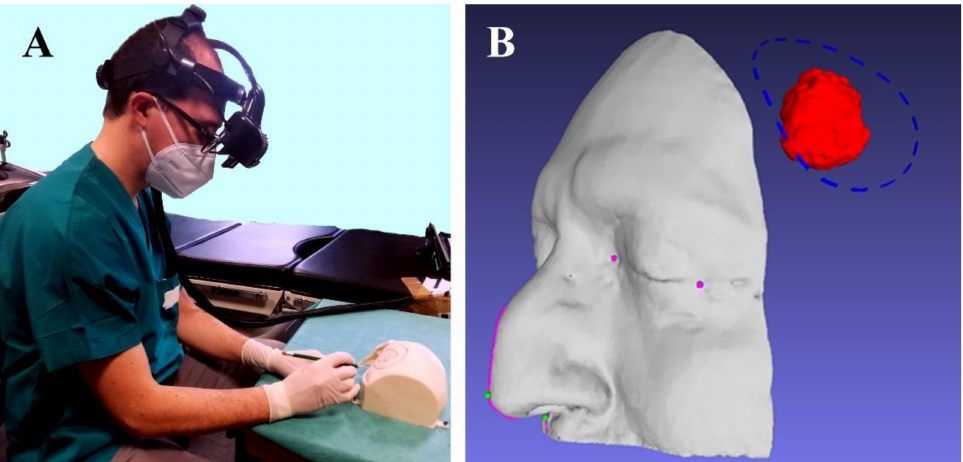
Figure 5. ( A ) The neurosurgeon drawing the craniotomy line on the manikin’s head with a pencil. ( B ) Shows the virtual content to be displayed by VOSTARS: craniotomy, meningioma, medial and lateral canthi, pronasal point at the anterior nasal apex and nasospinal and profile of the patient’s nose.